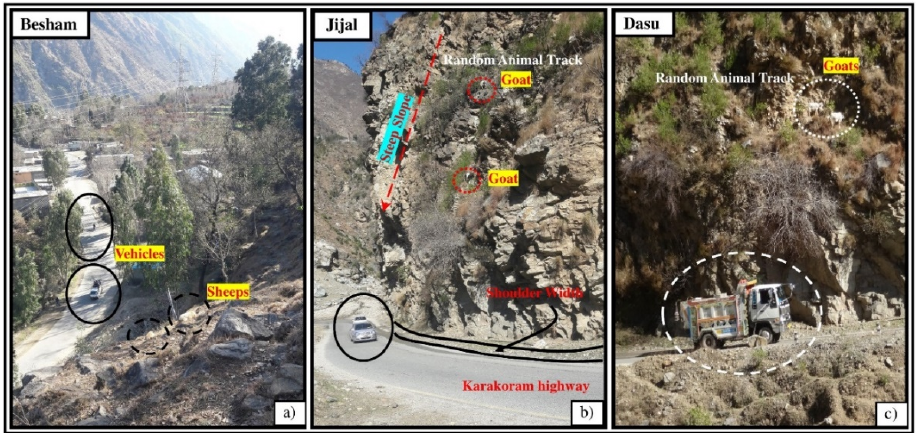
Figure 1. Quantification of rockfall activity caused by animal movement at lower and higher altitudes. ( a ) Sheep grazing at the gentle slope and lower altitude can push stones, which might cause moderate damage. ( b , c ) Stone falling caused by goats grazing at the steep slope and at the random track can directly damage the vehicles.